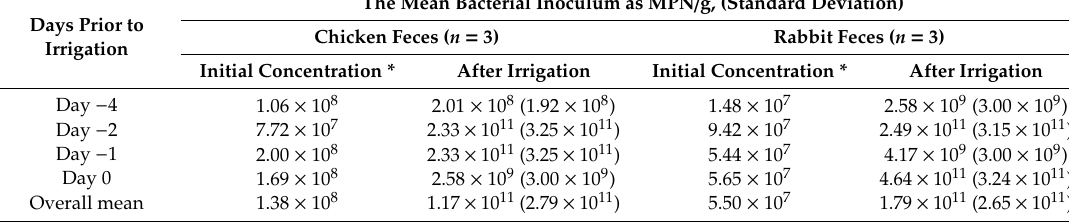
Table 1. Experiment A. Mean concentration of E. coli Rif r in 5 g of chicken and rabbit feces placed in the furrow up to four days prior to irrigation day (day 0) compared to E. coli Rif r concentrations measured immediately after